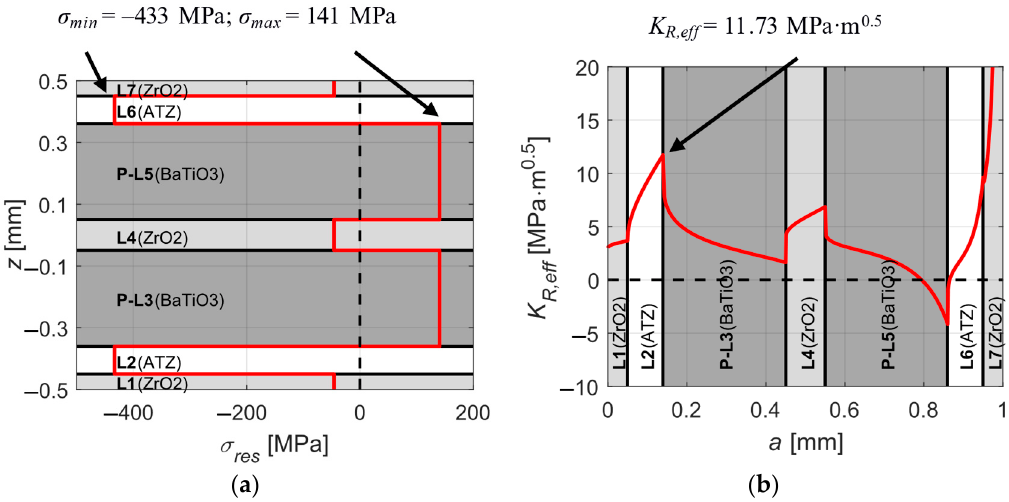
Figure 1. The calculated outcome for the ideal layer configuration loaded with Δ T = − 1430 °C: ( a ) Distribution of thermal residual stresses within the layers. ( b ) The apparent fracture toughness of the structure.